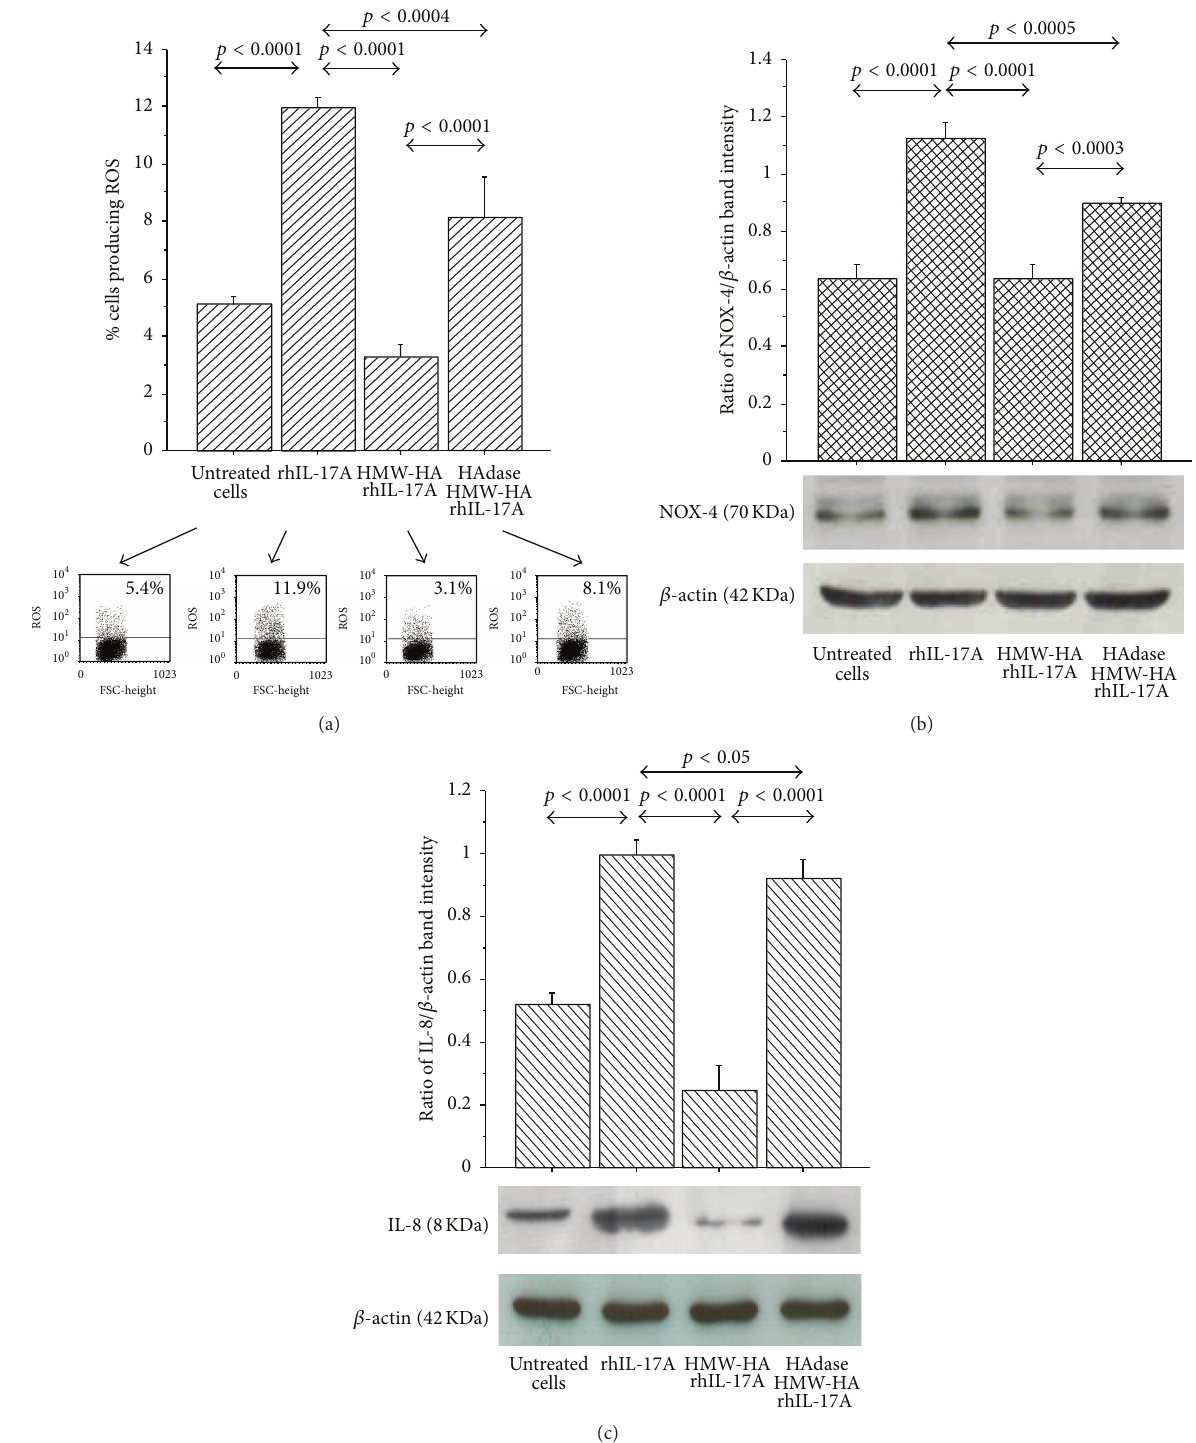
Figure 7: Specific effect of HMW-HA in RPMI 2650 cells stimulated with rhIL-17A. HMW-HA was incubated with HAdase 2.5 units/100 𝜇 g (60 ∘ C for 72hrs plus 65 ∘ C for 10min). The cells were preincubated with HMW-HA (100 𝜇 g/mL) or HAdase treated HMW-HA for 1h and stimulated with rhIL-17A (20 ng/mL) for 6hrs for ROS or 18hrs for NOX-4 and IL-8. (a) ROS production was evaluated in the cells by flow cytometry. Representative flow cytometry is shown. The results were expressed as the mean ± SD of 3 separate experiments; (b-c) NOX-4 and IL-8 protein synthesis were evaluated in the cell lysates by western blot. The bars represent ratio of band intensity and 𝛽 -actin of 3 separate experiments. Representative western blot is shown. ANOVA with Fisher’s test correction was used for the analysis of the data. 𝑝 < 0.05 was statistically